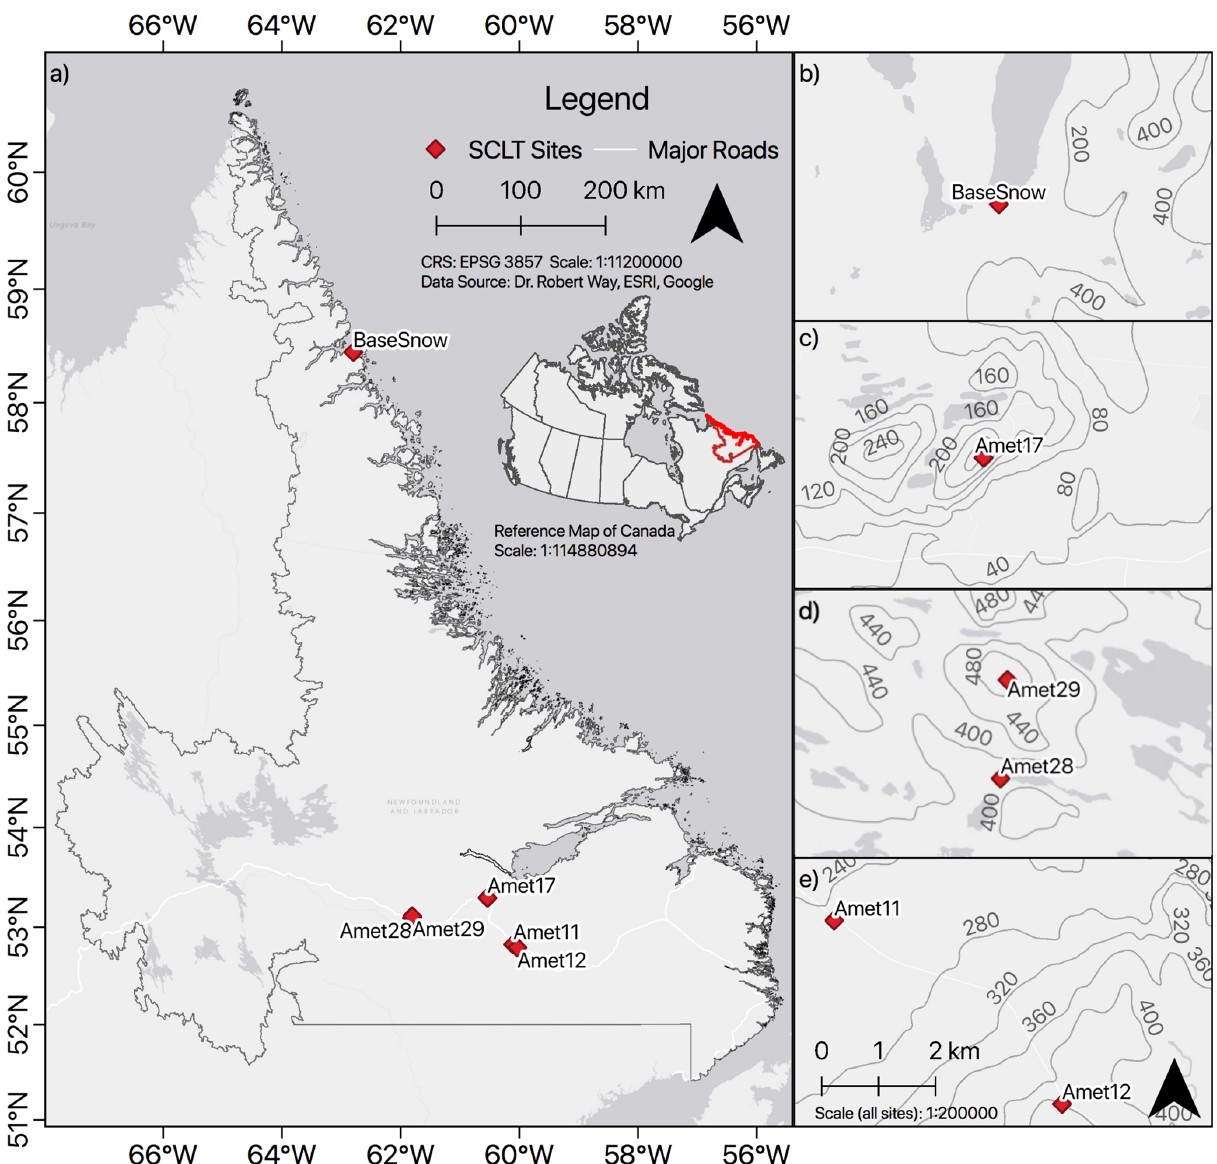
Figure 1. (a) Geographic distribution of light and temperature snow stake sites, with detailed topographic depictions of (b) BaseSnow in Torngat Mountains National Park, (c) Amet17 close to the municipality of Happy Valley-Goose Bay (HVGB), (d) Amet28 and Amet29 along the Trans-Labrador Highway between Churchill Falls and HVGB, and (e) Amet11 and Amet12 along the Trans-Labrador Highway south-east of